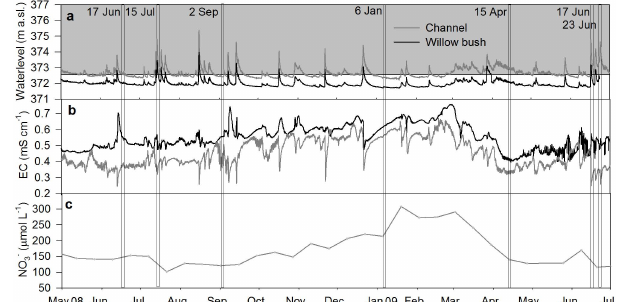
Fig. 2. Variations in water level (a) and electrical conductivity (EC) ( b ) in the channel and in the piezometer in willow bush (R041) from May 2008 until the end of June 2009 and bi-weekly NO − tration in the river Thur (http://www.naduf.ch/daten.htm) (c) . The gray area indicates the position of the overlying soil structure of the aquifer. Vertical bars designate the different sampling dates. Water level fluctuations in willow bush followed water level variations in the channel, reflecting high hydraulic connectivity. Electrical con- ductivity generally showed a slightly dampened and time-shifted signal in willow bush compared to the channel. During flood events in the periods June to October 2008 and May to July 2009, the elec- trical conductivity signal in willow bush was reverse to that of the